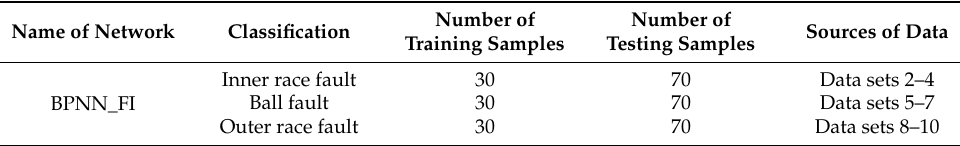
Table 3. Sample settings for the fault isolation layer.